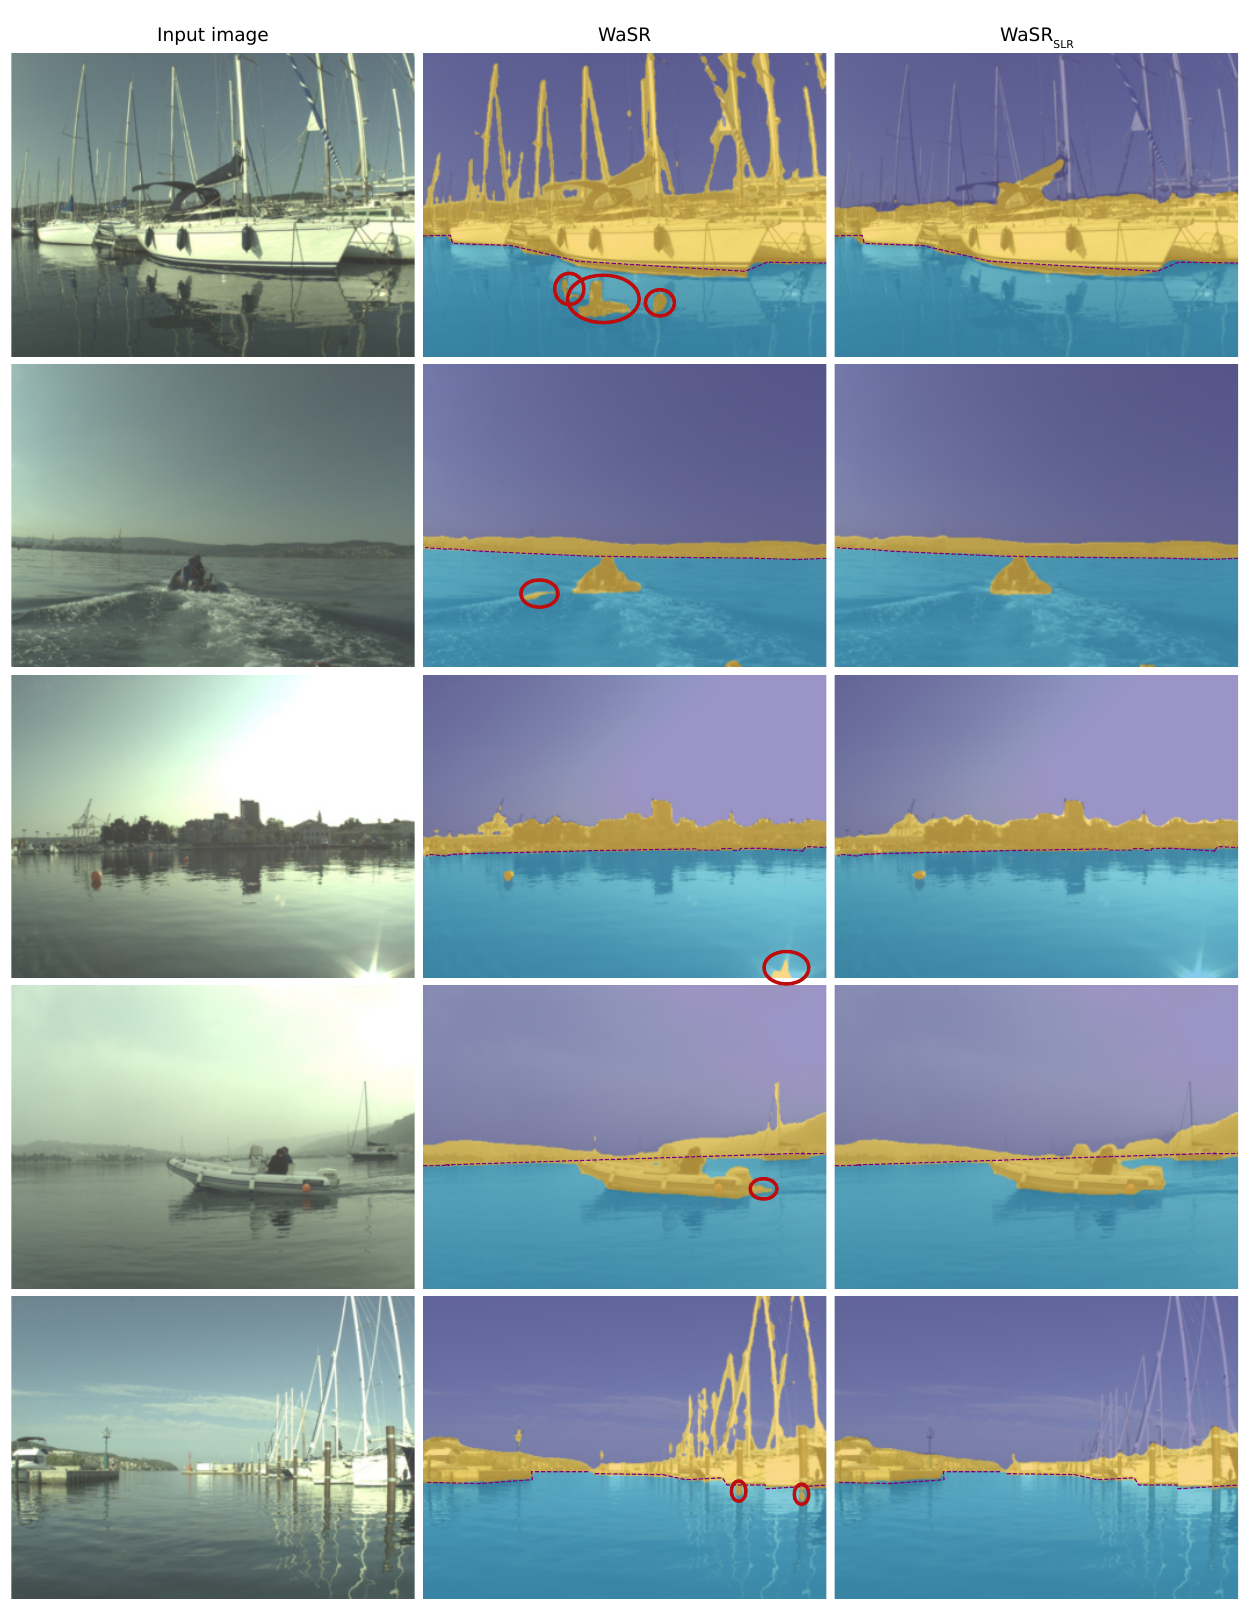
Figure 7. Comparison of WaSR and WaSR SLR on the MODS benchmark. Errors are highlighted with red circles. WaSR SLR is less sensitive to false-positive detections on object reflections (rows 1 and 5) and other challenging anomalies such as wakes (rows 2 and 4) and sun glitter (row